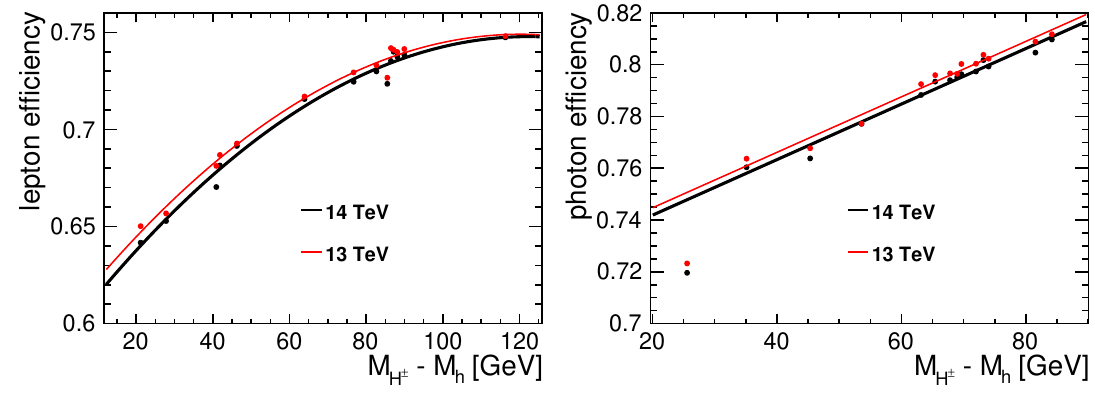
Figure 4 . The lepton tagging efficiency (left) and the photon tagging efficiency (right) are shown as a function of the mass difference between the H ± and h